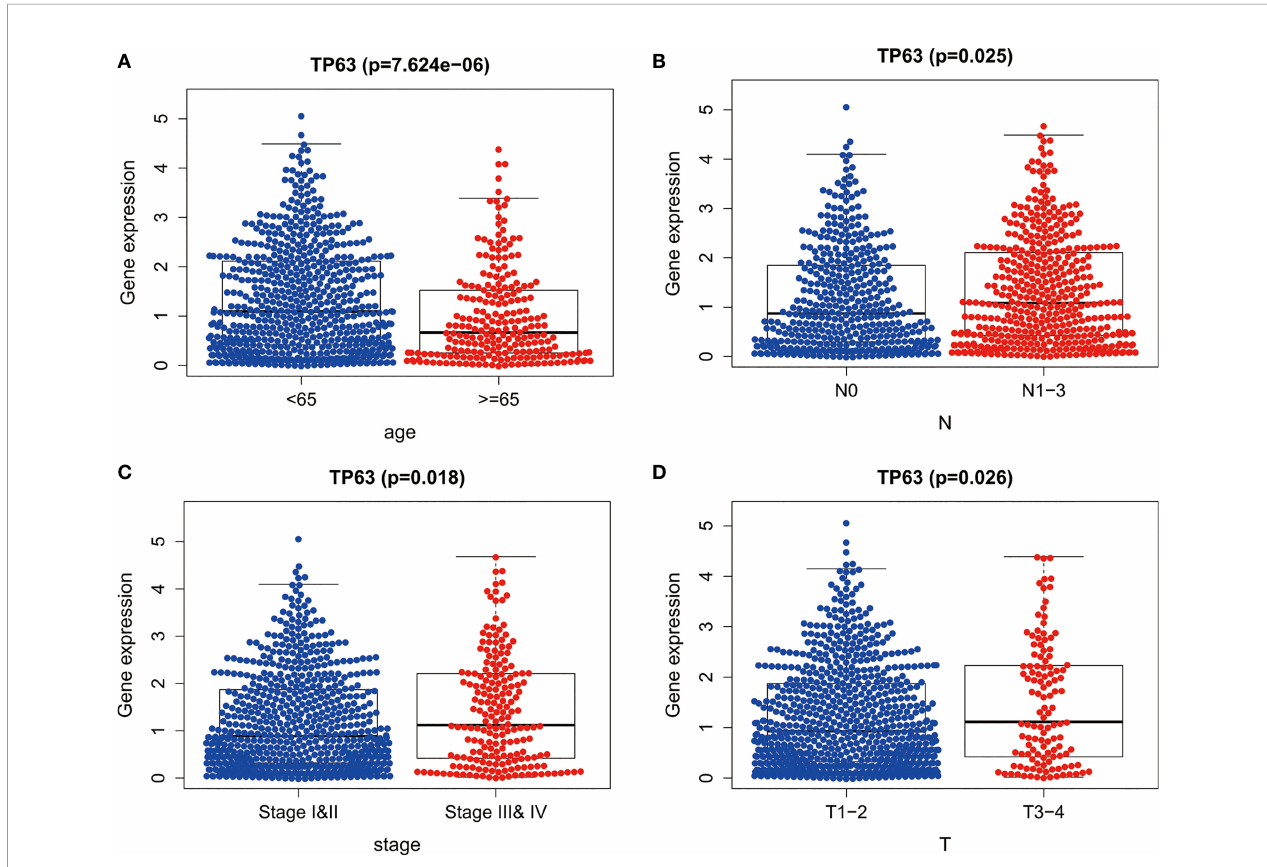
FIGURE 3 | The expression of TP63 between different clinical features of breast cancer. The P values of (A) age, (B) lymph node metastasis, (C) TNM stage and (D) tumor size between the two groups were all less than